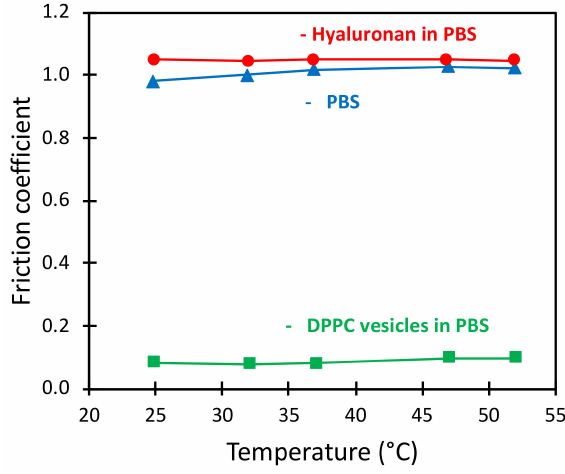
Figure 9. The friction coefficient as a function of temperature measured in MTM in pure PBS solution and in PBS containing HA or DPPC vesicles at concentrations of 0.5 mg/mL.